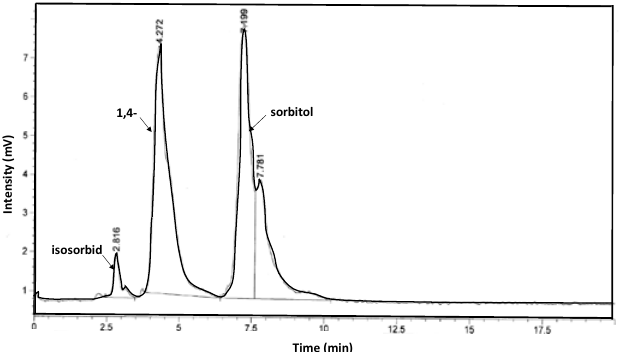
Figure 6. High-performance liquid chromatography (HPLC) chromatogram of products.